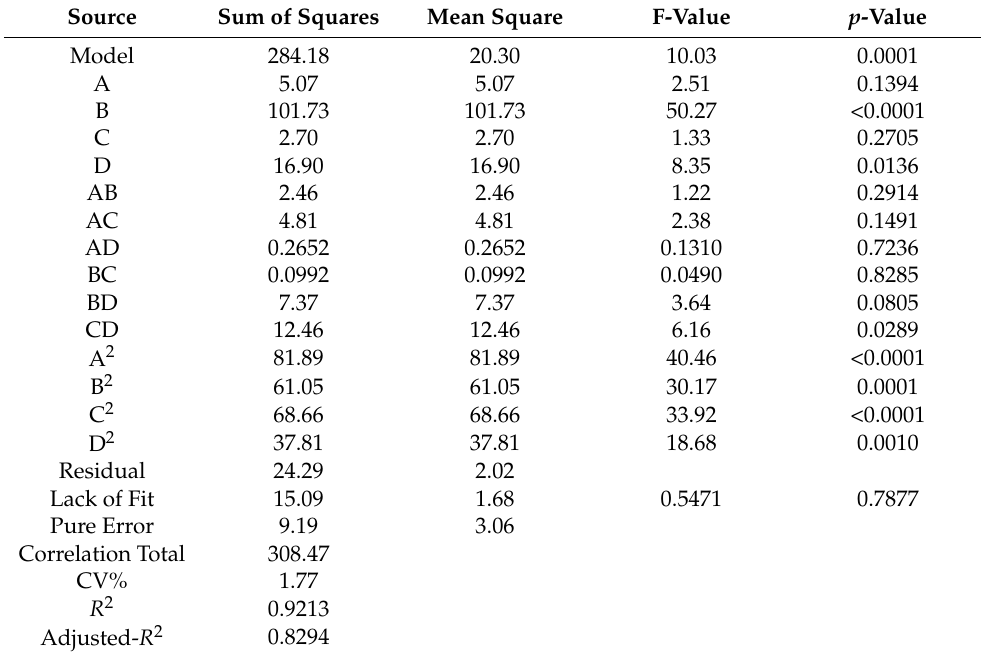
Table 4. Analysis of variance (ANOVA) for testing the fitness of the regression